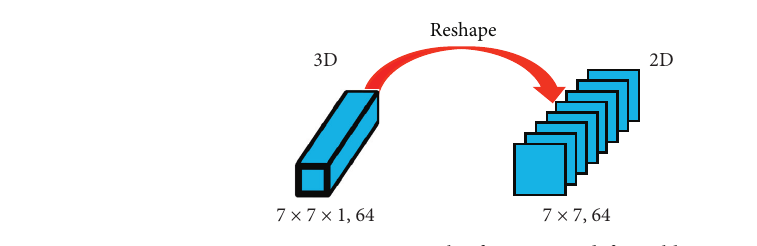
Figure 3: Framework of 3D to 2D